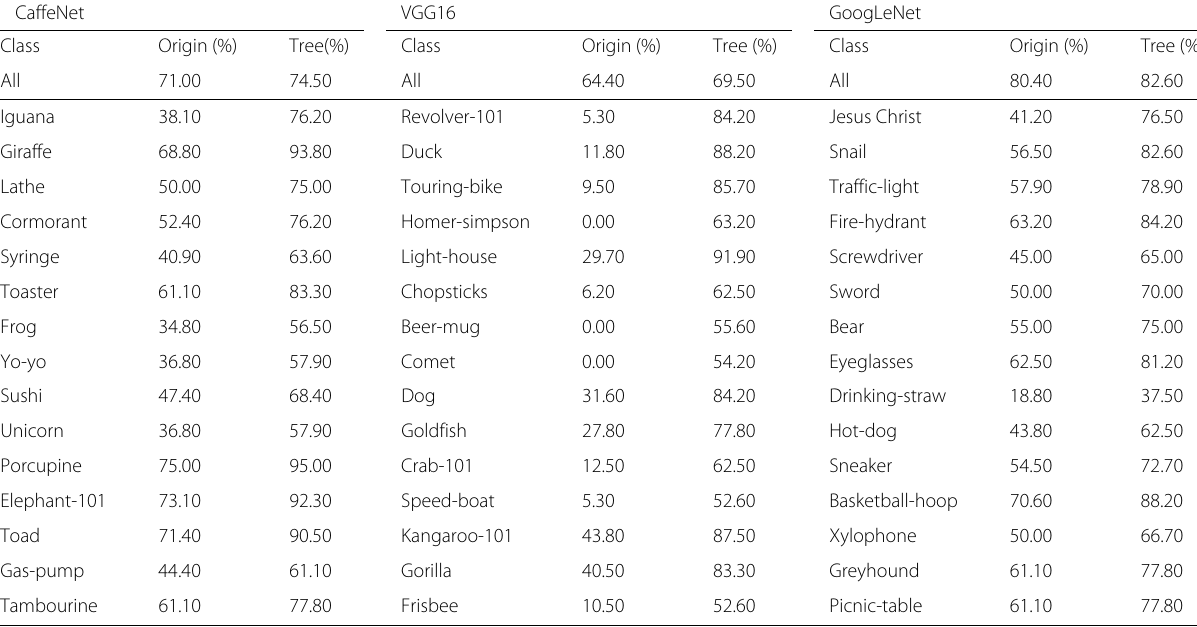
Table 2 The accuracy of the Tree-CNN and the original network on Caltech101, which includes CaffeNet, VGG16, and GoogLeNet